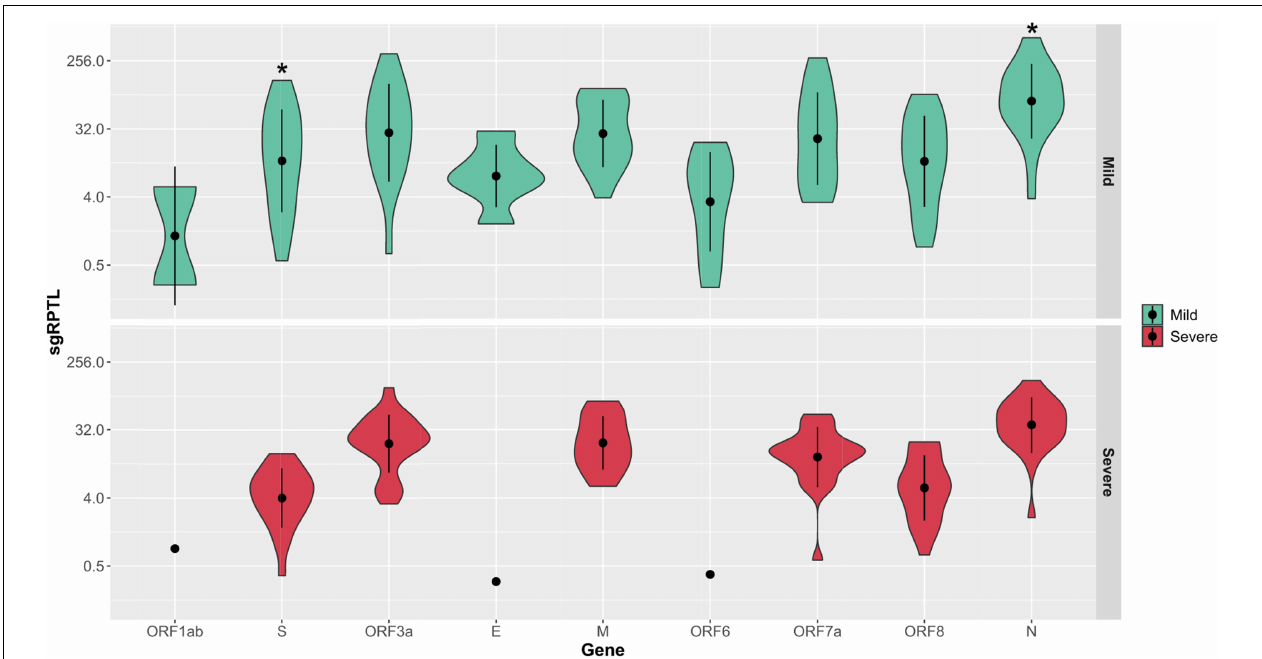
FIGURE 5 | Distribution of sgRPTL counts across all genes. sgRNA was detected in in the mild (red) and severe (green) clinical cohorts. Statistical significance ( p ≤ 0.05) is denoted by (*). S sgRNA detected in n = 24/26 severe and n = 21/25 mild genomes, ORF3a in 24/26 severe genomes and 17/25 mild genomes, E in 1/26 severe genomes and 6/25 mild genomes, M in 20/26 severe genomes and 15/25 mild genomes, ORF6 in 1/26 severe genomes and 11/25 mild genomes, ORF7a in 24/26 severe genomes and 18/25 mild genomes, ORF8 in 22/26 severe genomes and 20/25 mild genomes and N in 25/26 severe genomes and 24/25 mild